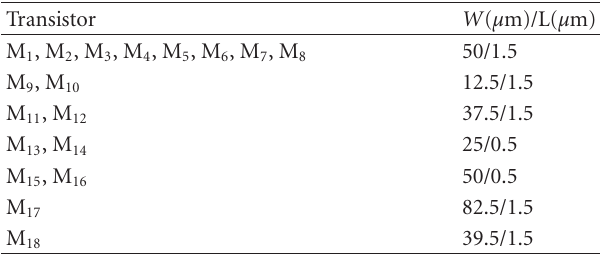
Table 1: Transistor aspect ratios of the ICCII − are shown in Figure 1(c).